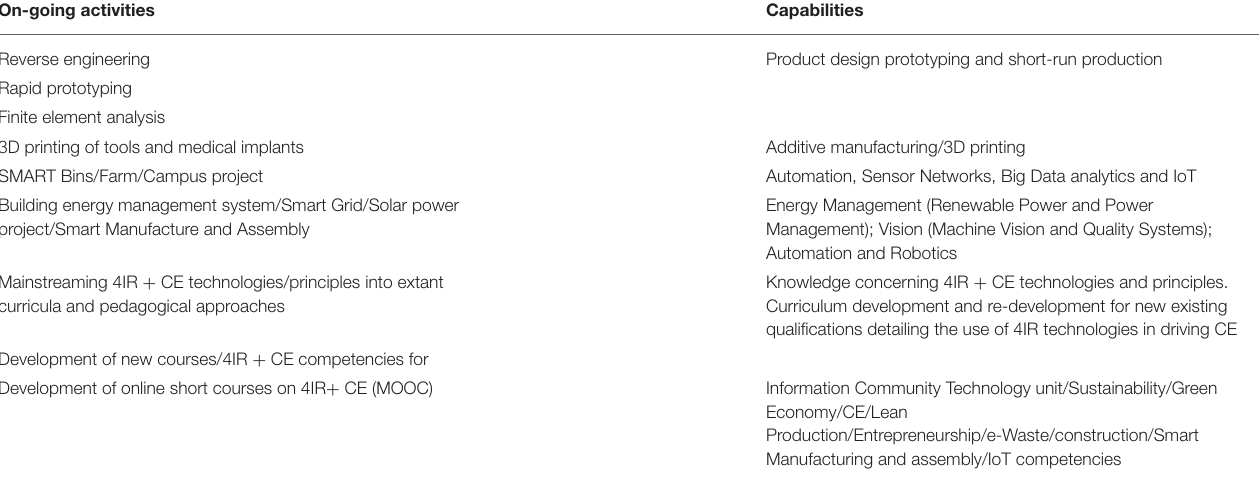
TABLE 2 | CE/4IR Capabilities and on-going activities at